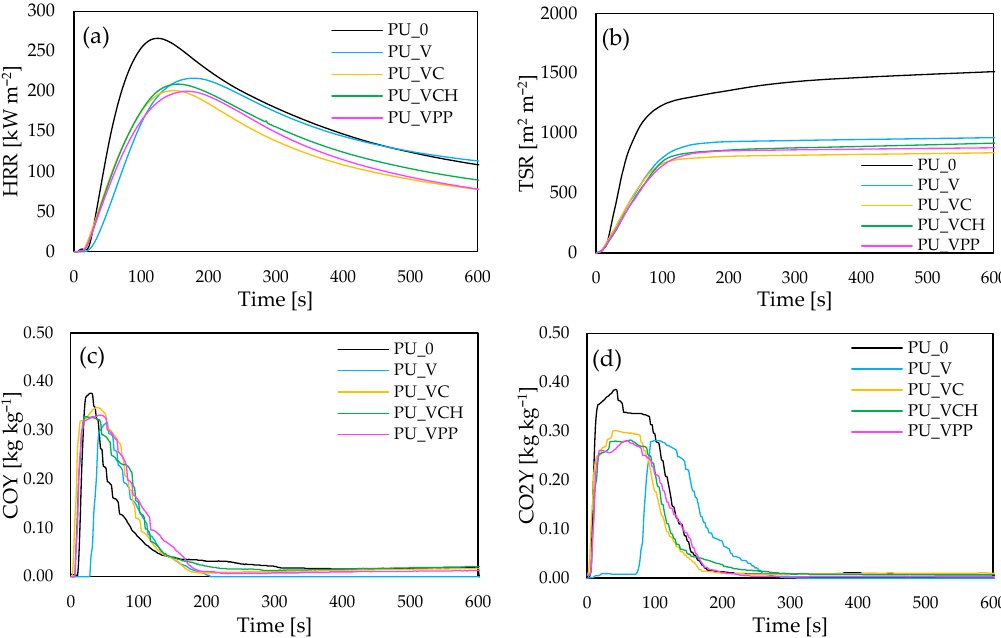
Figure 7. The results of ( a ) peak heat release (pHRR), ( b ) total smoke release (TSR), and an average yield of ( c ) CO and ( d ) CO 2 .